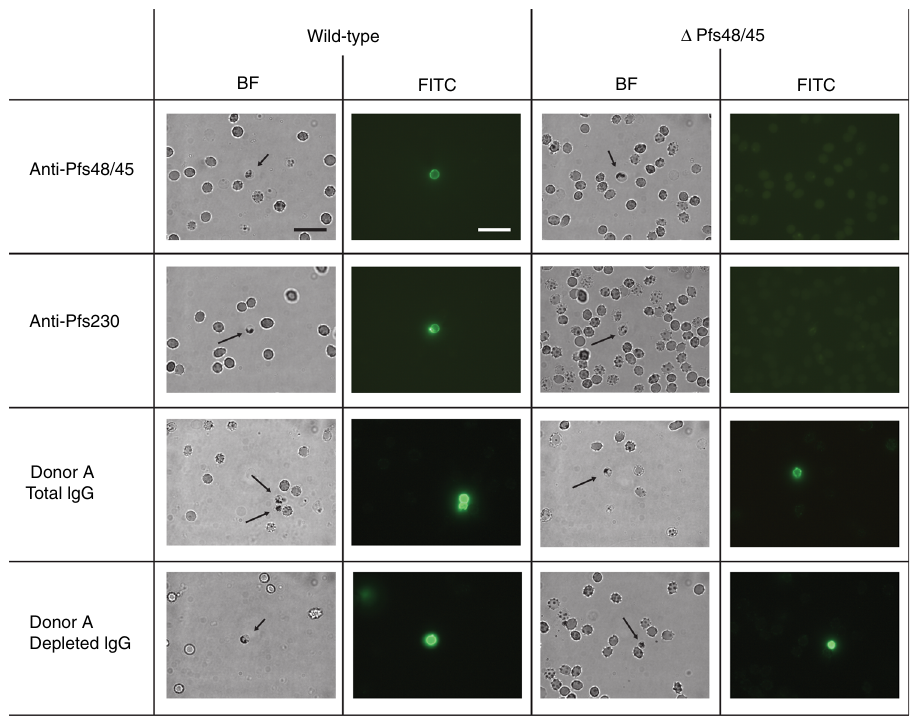
Fig. 4 Gamete surface immuno- fl uorescence assay (SIFA) using wild-type and Pfs48/45 knockout (KO) NF54 gametes, with Pfs48/45 mAb, Pfs230 mAb, and IgG from a malaria-exposed serum donor. Donor IgG is from donor A in Table 2, and was performed using total IgG, and total IgG depleted of α -Pfs48/ 45-10c and α -Pfs230 (230CMB) IgG. Δ Pfs48/45 = Pfs48/45 KO 3 . BF Bright- fi eld, FITC fl uorescein isothiocyanate. Anti-Pfs48/45 is mAb 45.1, and